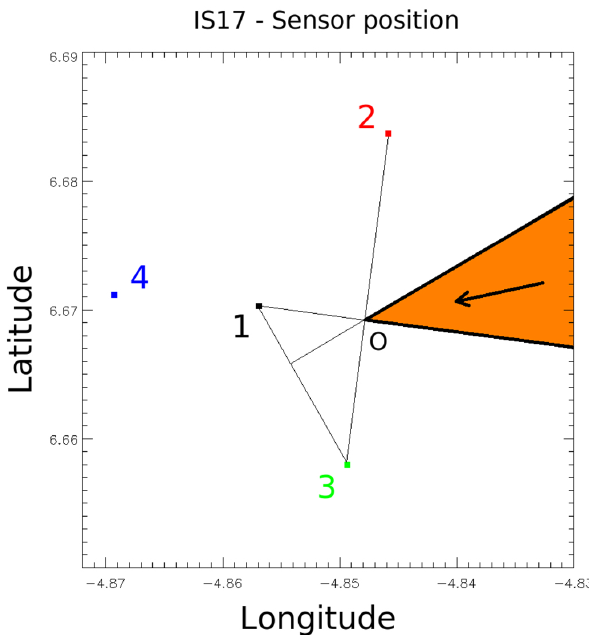
Fig. 2. Geographical position of the four microbarometer sensors of station IS17. The region within the orange area indicates an ap- proximate estimate of the possible arrival angles, with respect to the point O, of the pressure disturbance wave (assuming a plane wave), according to the temporal order of pressure peak detection (recorded first at station 2 and then at 3, 1 and